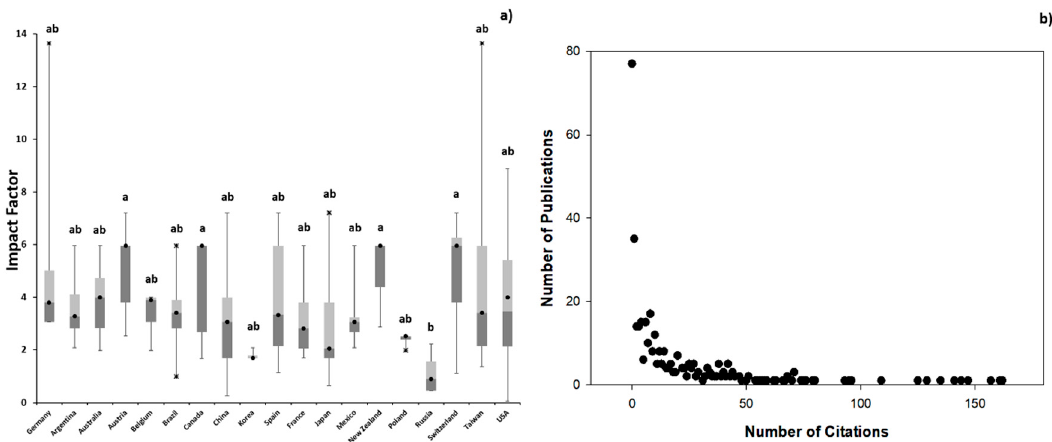
Figure 3. ( a ) Mean impact factors of the journals in which papers on chloroplast markers were published by corresponding authors of di ff erent nationalities (more than two publications). The means with di ff erent letters above them are significantly di ff erent from each other, based on Tukey’s test ( p ≤ 0.05). ( b ) The number of papers (based on estimates of genetic diversity obtained from cpDNA sequences) ranked by the number of times they have been cited in other publications.